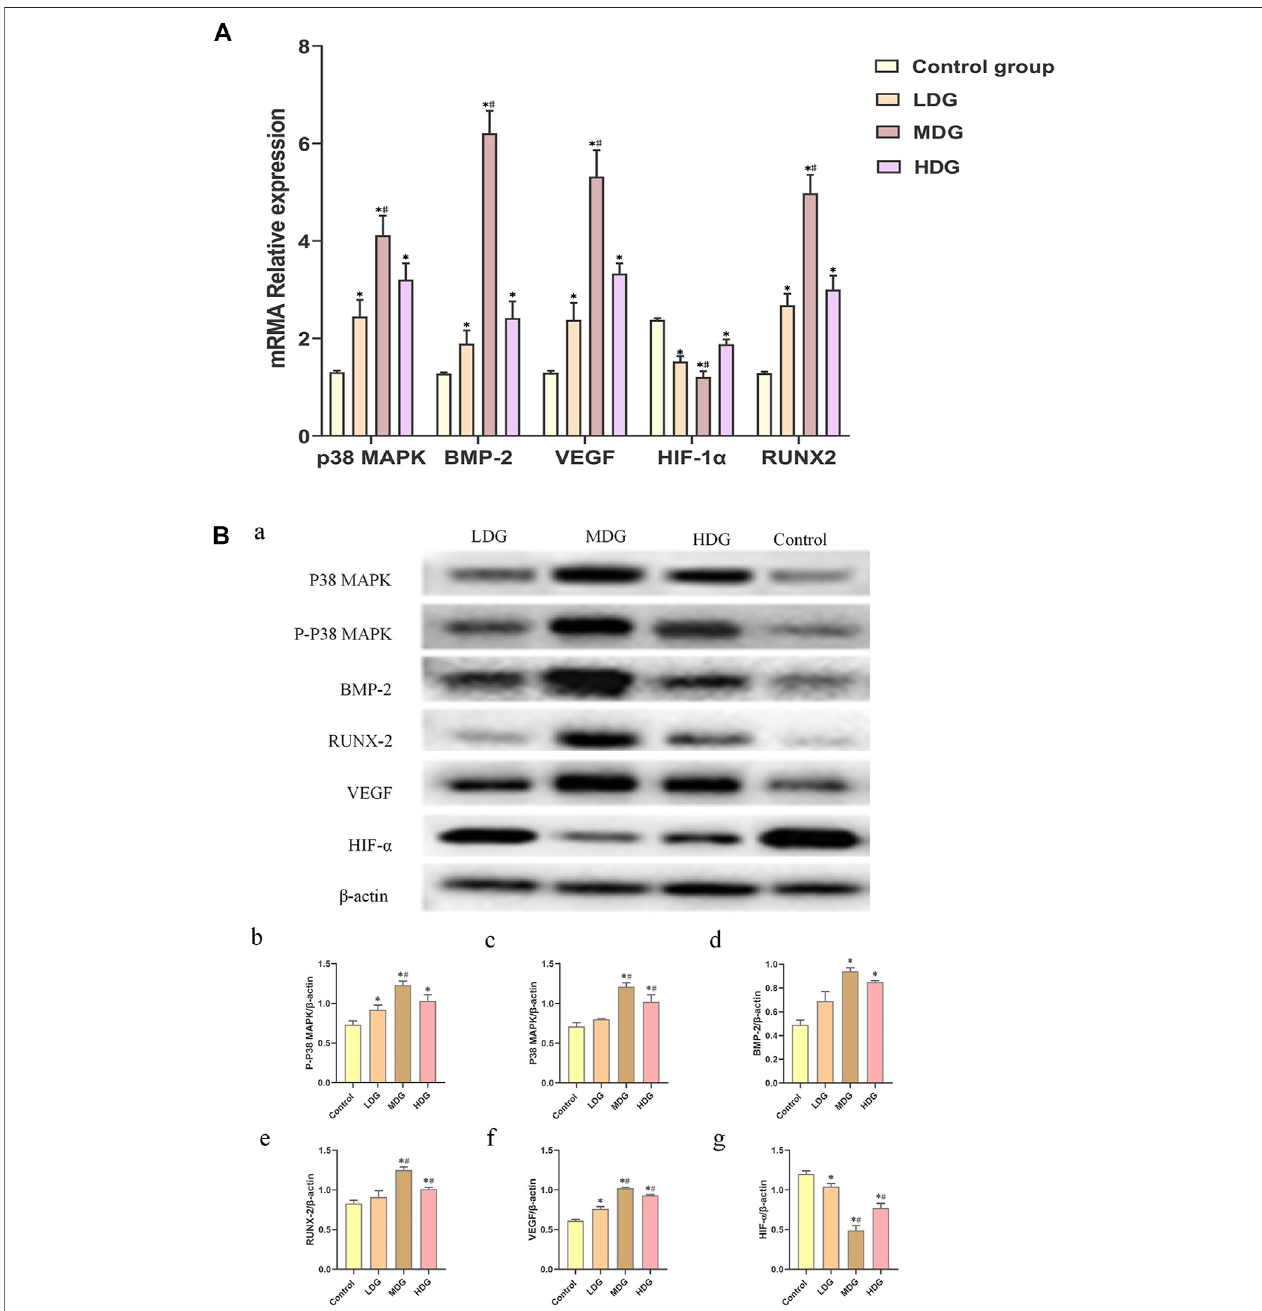
FIGURE 9 | The expressions of p38 MAPK, BMP-2, VEGF, HIF-1 α , and RUNX-2 mRNA on BMSCs by quantitative real-time PCR. The data are expressed as the mean ± SEM of three independent experiments. * p < 0.05 vs. control group, # p < 0.05 vs. the TFDR low dosage group, TFDR high dosage group. (B) (a) p38 MAPK, p-p38 MAPK, BMP-2, RUNX-2, VEGF, and HIF-1 α protein expression on BMSCs detected by western blot analysis. (B – G) were statistical analysis of (A) . The data are expressed as the mean ± SEM of three independent experiments. * p < 0.01 vs. the Control group; * p < 0.01 vs. the TFDR low dosage group.